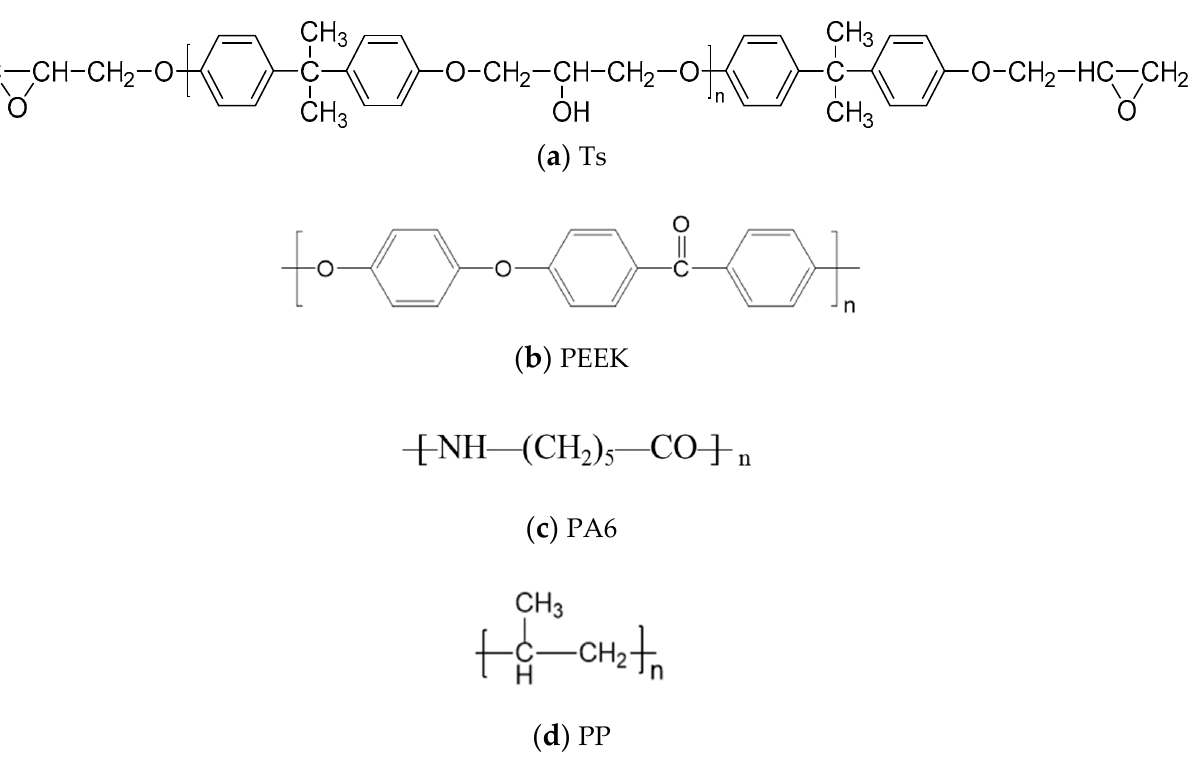
Figure 16. Molecular structure of Ts resin and three kinds of thermoplastic resin fillers of ( a ) Ts, ( b ) PEEK, ( c ) PA6 and ( d )